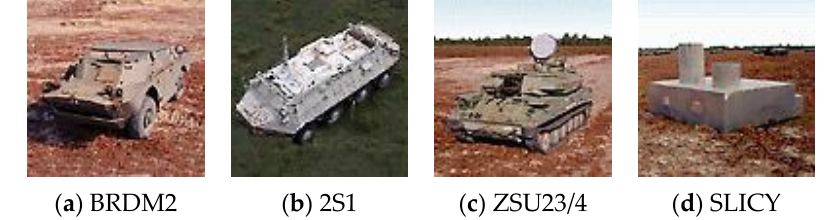
Figure 17. The optical images of four target. ( a ) BRDM2; ( b ) 2S1; ( c ) ZSU234; ( d ) SLICY.